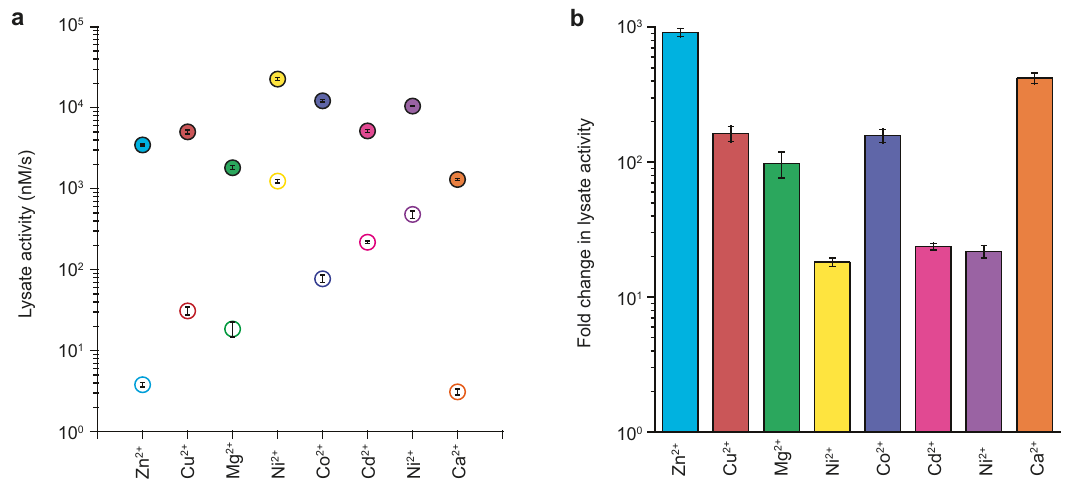
Fig. 2 Effect of all substitutions when introduced in different metal environments. a The lysate activity of the ancestral DHCH genotype (open circles) and fully derived MPH genotype (solid circles) in eight different metal environments. Activities shown are the average of three biological replicates, with error bars indicating the standard deviation. b The collective effect of all fi ve historical substitutions (fold-change in lysate activity between the ancestral genotype and the derived genotype) in each metal environment. Activities shown are the average of three biological replicates, with error bars indicating the standard deviation. The activities of puri fi ed enzymes in the eight different metal environments is presented in Supplementary Fig.